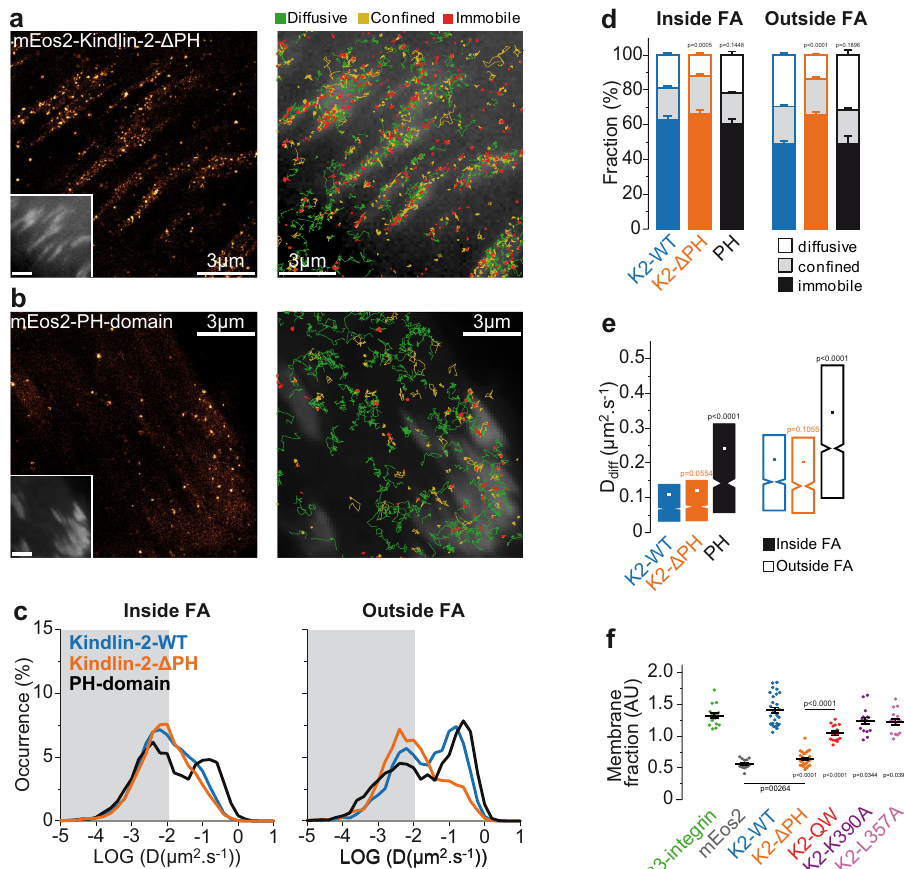
Fig. 4 Kindlin-2 membrane recruitment and diffusion depends on the pleckstrin homology domain. Left: Super ‐ resolution PALM intensity images of mEos2 ‐ kindlin-2- Δ PH ( a ) and mEos2 ‐ PH-domain of kindlin-2-WT ( b ) in MEFs obtained from a sptPALM sequence (50 Hz, >80 s). Inset: low resolution image of GFP-paxillin, which was co-expressed for FAs labeling (scale bar: 3 µ m). Right: color-coded trajectories overlaid on FAs labeled by GFP-paxillin (greyscale) show the diffusion modes: free diffusion (green), con fi ned diffusion (yellow) and immobilization (red). c Distributions of the diffusion coef fi cient D computed from the trajectories of mEos2 ‐ kindlin-2-WT (blue), mEos2 ‐ kindlin-2- Δ PH (orange) and mEos2 ‐ PH-domain of kindlin-2-WT (black) obtained inside (left) and outside FAs (right), are shown in a logarithmic scale. The gray area including D values inferior to 0.011 µ m².s − 1 corresponds to immobilized proteins. Values represent the average of the distributions obtained from different cells. d Fraction of proteins undergoing free diffusion, con fi ned diffusion or immobilization inside (left) and outside FAs (right) for mEos2 ‐ kindlin-2-WT, mEos2 ‐ kindlin-2- Δ PH, and mEos2 ‐ PH-domain of kindlin-2-WT (same color-code). Values represent the average of the fractions obtained from different cells (error bars: SEM). e Box plots displaying the median (notch) and mean (square) ± percentile (25 – 75%) of diffusion coef fi cients corresponding to the free diffusion trajectories inside (left) and outside FAs (right). Results of sptPALM (in a – e ) for mEos2 ‐ kindlin-2-WT (15 cells), mEos2 ‐ kindlin-2- Δ PH (28 cells) and mEos2 ‐ PH-domain of kindlin-2-WT (18 cells) correspond to pooled data from three independent experiments. f Fraction of proteins recruited at the membrane de fi ned as the ratio of the membrane-level fl uorescence signal (TIRF) to the total fl uorescence signal of the cell (epi fl uorescence). Results of membrane fraction (in f ) for mEos2 ‐ kindlin-2-WT (28 cells), mEos2 ‐ kindlin-2- Δ PH (27 cells) correspond to pooled data from two independent experiments, whereas results for β 3-integrin-mEos2 (17 cells), cytosolic mEos2 (13 cells), mEos2-kindlin-2-QW (15 cells), mEos2-kindlin-2-K390A (15 cells) and mEos2-kindlin-2-L357A (15 cells) correspond to one experiment. Where indicated, statistical signi fi cance was obtained using two ‐ tailed, non ‐ parametric Mann – Whitney rank sum test. Inside and outside FAs, the different conditions were compared to the corresponding mEos2 ‐ kindlin-2-WT condition. Otherwise, a black line indicates which conditions were compared. The exact P values are indicated on the fi gure except when P < 0.0001. Source data are provided as a Source Data fi